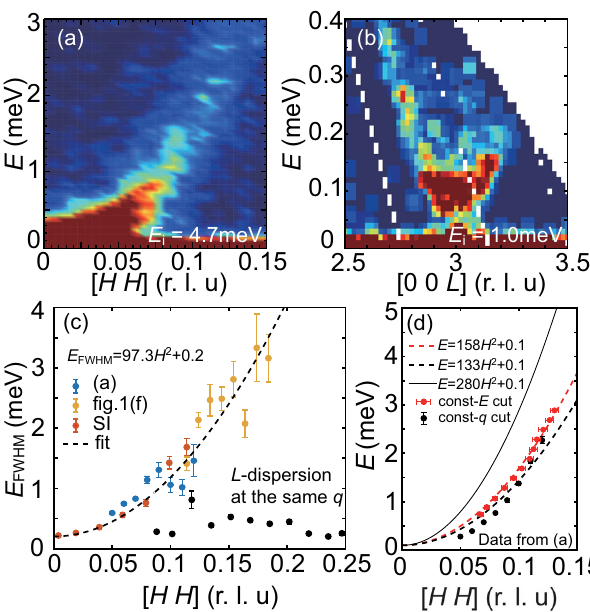
Fig. 3 Details of in-plane magnon broadening. a INS data along the [ H , H ] direction with E i = 4.7 meV and L = 3. b INS data along the [0, 0, L ] direction showing a ~ 0.1 meV spin gap at the Γ point. c Magnon line-width (FWHM) as a function of reciprocal lattice vector [ H , H ], and its comparison with the L -dispersion FWHM (black dots) at the same momentum transfer. d Long-wavelength magnon energy as a function of [ H , H ] with quadratic fi ts (dashed lines). The solid line indicates the expected magnon dispersion calculated using LSWT with fi tted parameters given in the text. The vertical and horizontal error bars in c and d represent uncertainty in fi tted energy in meV and [ H , H ] in r.l.u.,